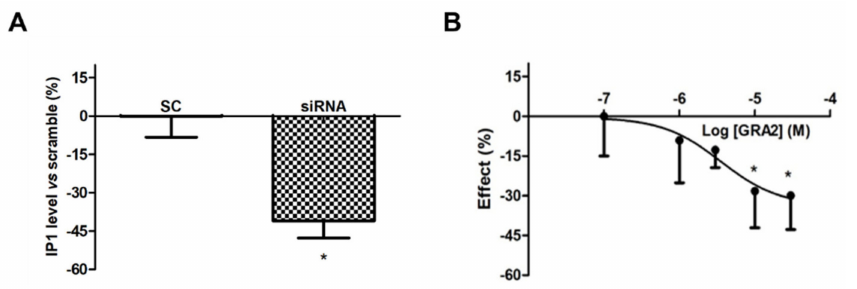
Figure 3. Effect of GPR21 gene silencing and GRA2 treatment on IP1 production. GPR21 constitutive activation was quantified by measuring the intracellular IP1 level in HepG2 cells transfected with non-silencing siRNA (SC, Scramble) or silenced with siRNA against GPR21 for 72 h (panel ( A )) as well as in HepG2 cells treated with increasing concentrations of the inverse agonist (3–30 µ M, for 1 h, panel ( B )). Data are expressed as mean ± SEM of four independent experiments run in duplicate. Values are expressed in % vs. control or scramble. * p < 0.05 vs. control or